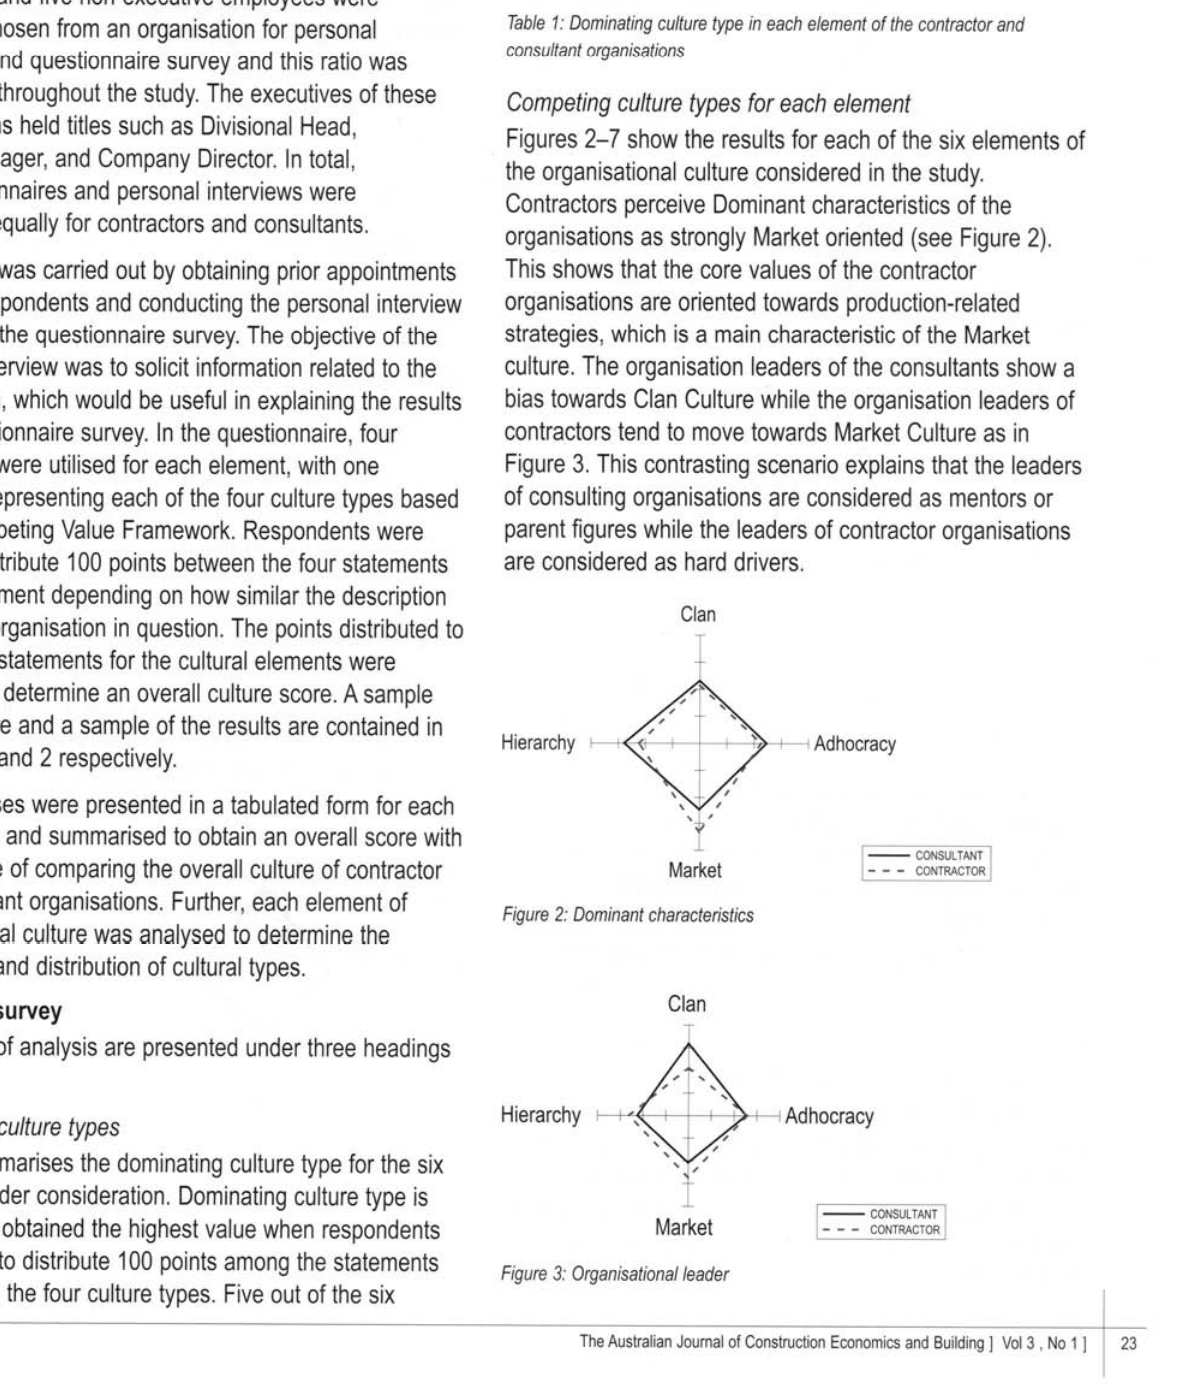
Figure 3: Organisational